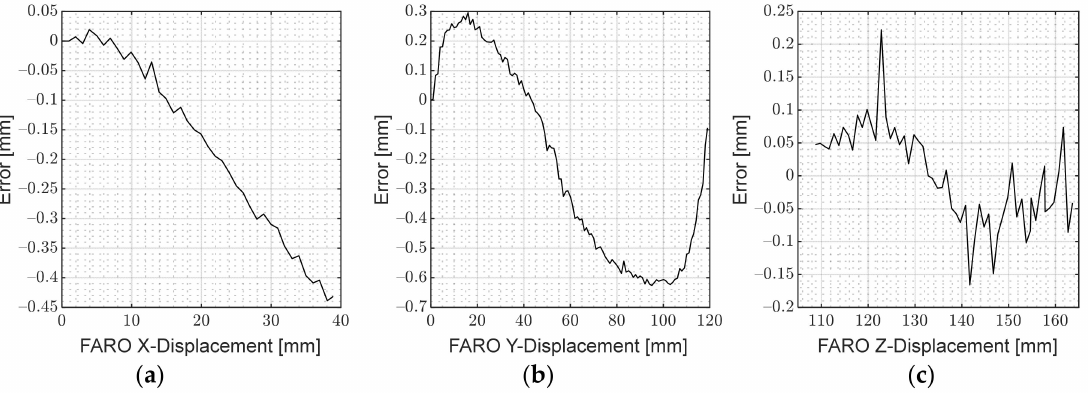
Figure 10. PRSOI-IRT: ( a ) X-error; ( b ) Y-error; ( c ) Z-error. For the x- and y-axis error determination, both the optical algorithm and FARO arm were zeroed at one corner of the field of view (FOV) of the camera; then, they were translated in 1 mm increments until the brick reached the opposite corner of the FOV. The x- and y-axis error are shown in Figure 10a and b, respectively. The maximum and RMS error was 0.4386 mm and 0.2296 mm for x, and 0.6262 mmm and 0.3943 mm for y. The x-axis error shows a linear trend, which is likely due to misalignment of the camera and translation table. The y-axis error has a systematic sine-like error, which may be due to the 3D hemisphere centre of mass of the LEDs not being exactly the same as the 2D centre of mass. Nevertheless, the errors and noise are small, testifying to a rigorous and accurate image filtering methodology, a robust correspondence algorithm, and precise